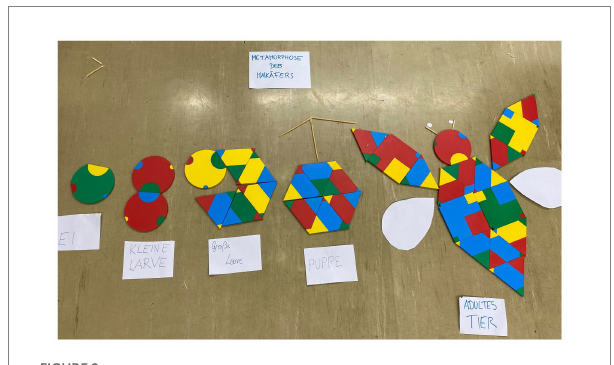
FIGURE 9 Solution of task 2, representing the life cycle of a